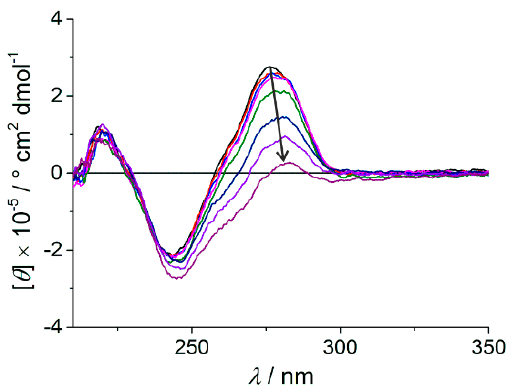
Figure 3. Circular dichroism (CD) spectra of the duplex comprising a central 6PP:T base pair in the presence of increasing amounts of AgNO 3 (0, 0.25, 0.5, 0.75, 1, 1.5, 2, 3 equiv.). The arrow indicates the direction of the changes upon the addition of AgNO 3 .